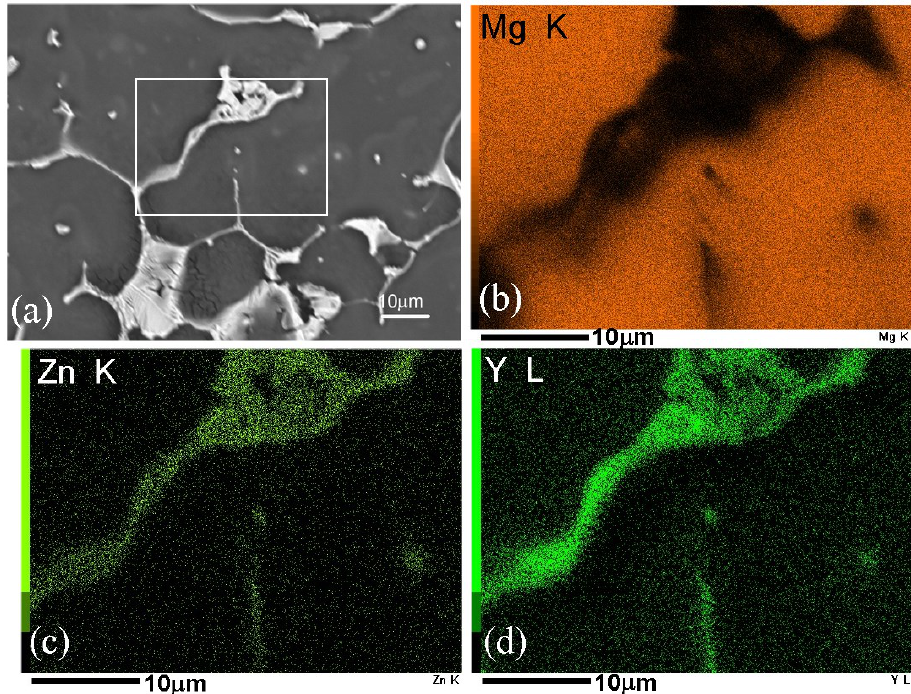
Figure 5. ( a ) A backscattered SEM image showing the dendritic structure in chill-cast alloy. The EDS elemental maps of an area marked by a rectangle in ( a ): ( b ) Mg-K, ( c ) Zn-K and ( d ) Y-L show the interdendritic phase to be a ternary.